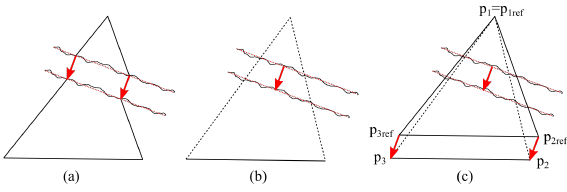
Figure 6. (a): crack through the reference triangle; (b): new triangle in the deformed state; (c): both triangles, vertex p 1 ref in reference and deformed state have the same position